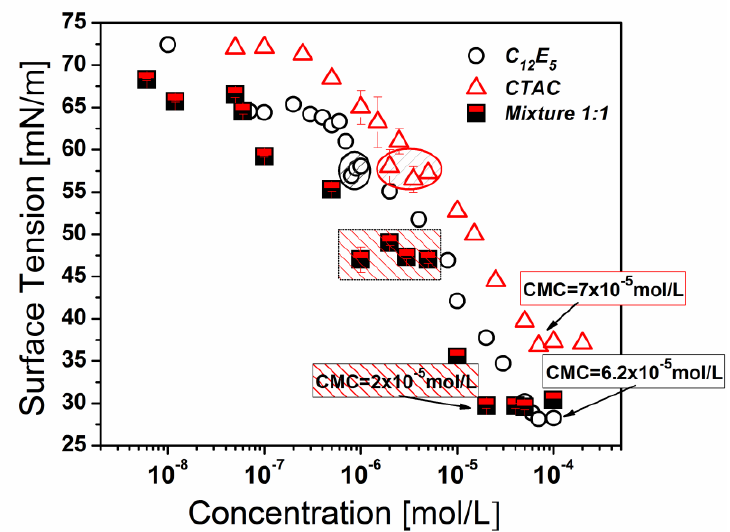
Figure 2. Equilibrium surface tension isotherms of aqueous solutions of 1:1 mixture C 12 E 5 / CTAC and of single surfactants CTAC and C 12 E 5 ; 0.1 mol / L NaCl is added to all solutions and the temperature is 20 °C.